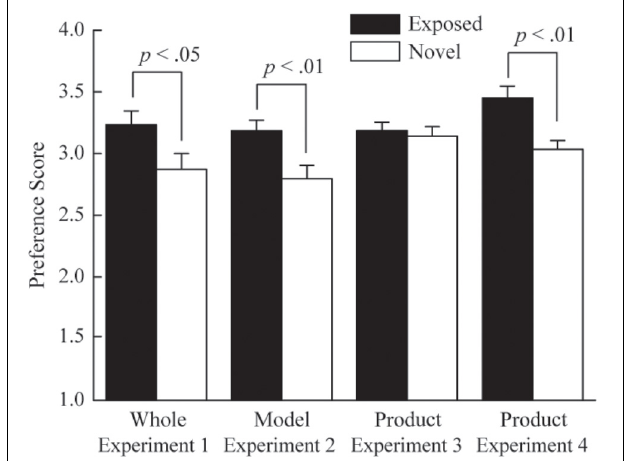
FIGURE 2 | Mean preference scores in Experiments 1–4 (Error bars are MSE). The black and white bars indicate the results in the exposed and novel conditions, respectively. The labels of the x-axis denote the experiment number and objects that were